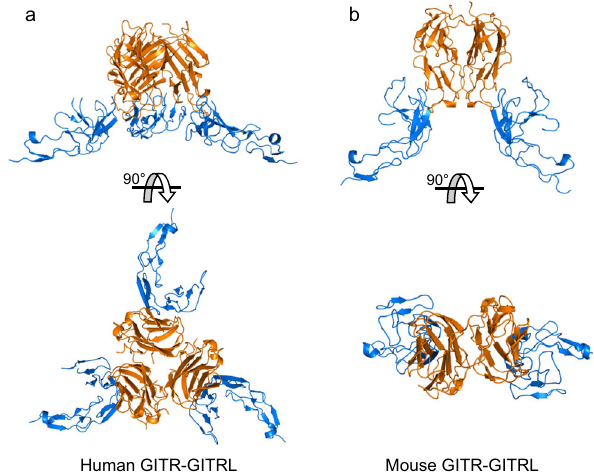
Fig. 4 Overview of human and mouse ligand and receptor complexes. Human GITR – GITRL forms a 3:3 receptor – ligand complex ( a ), while mouse GITR – GITRL forms a 2:2 receptor complex ( b ). The ligand is colored orange and the receptor is